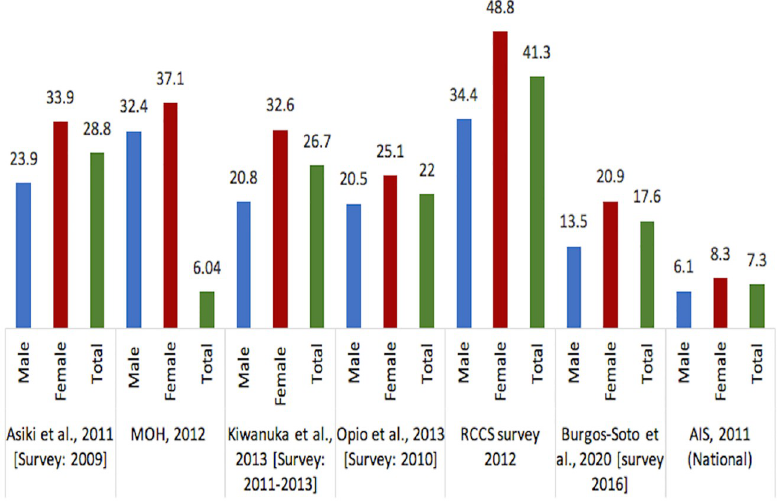
Fig 4. Prevalence of HIV in fishing communities. AIS: AIDS Indicator Survey (national data from the general population); UPHIA: Ugandan Population-based HIV Impact Assessment 2016–2017. The numbers represent the prevalence reported as percentage